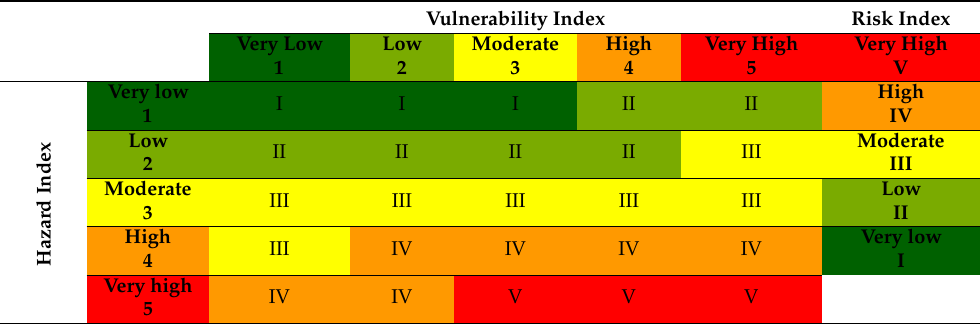
Table 15. Classification Matrix for the risk of overtopping and flooding in the study area (Costa da